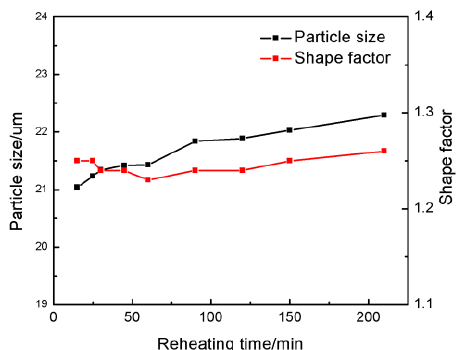
Figure 8. Variations in the primary particle size and shape factor of the bulk alloy with heating time after heating for 15 min at 640 °C.